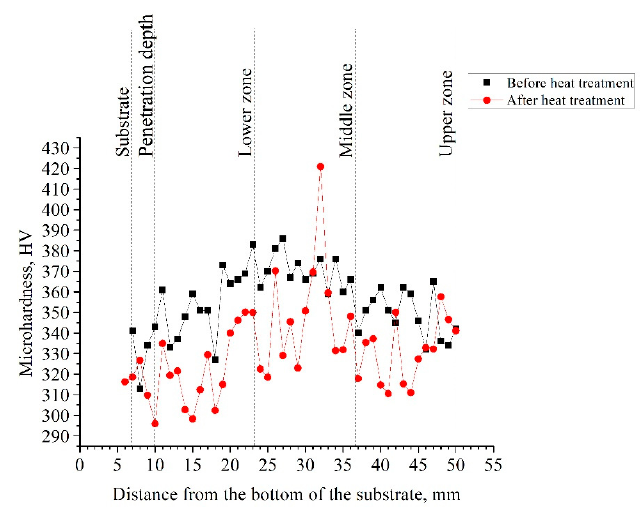
Figure 10. Microhardness measurements of the as-deposited and heat-treated specimens.